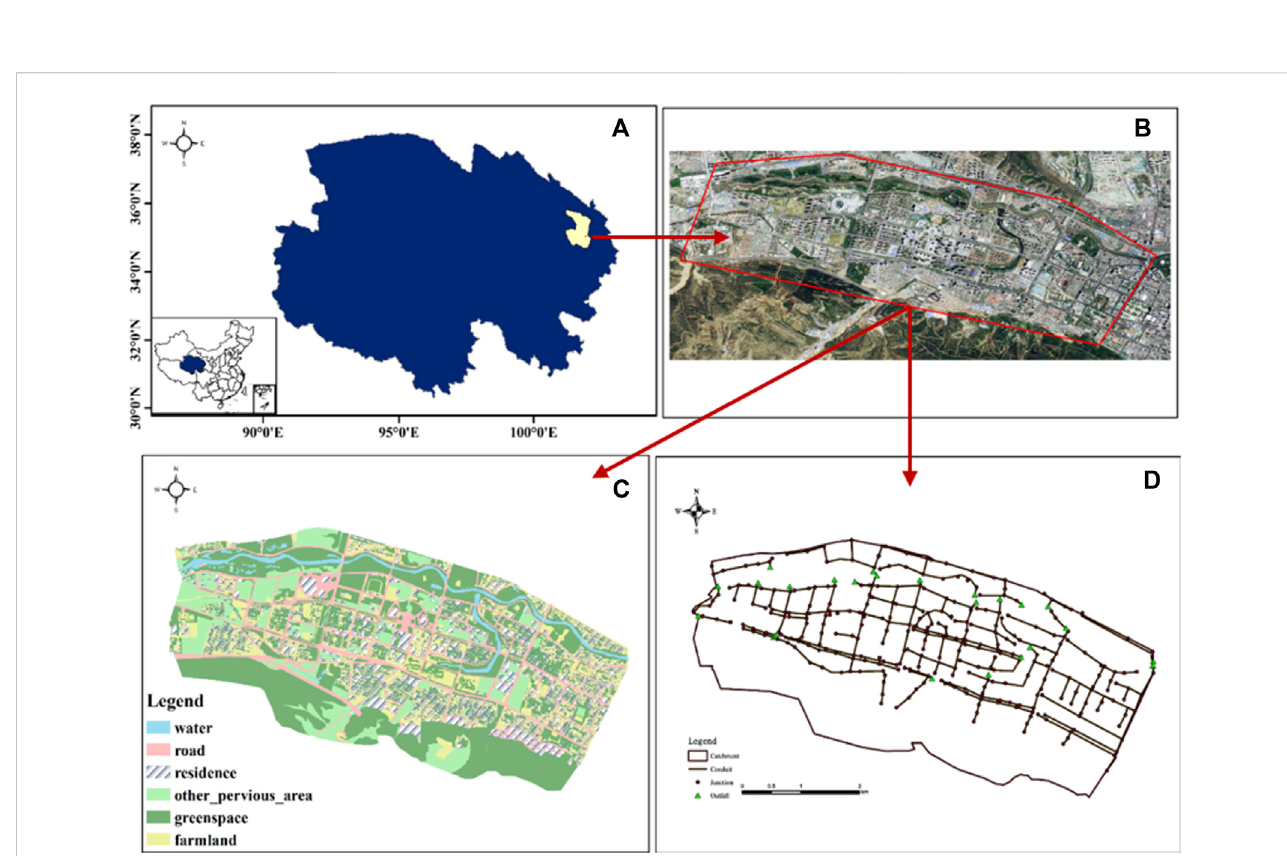
FIGURE 2 (A) Geographicallocationofthestudyarea; (B) Imagepictureofthestudyarea; (C) Thelanduseofthestudyarea; (D)